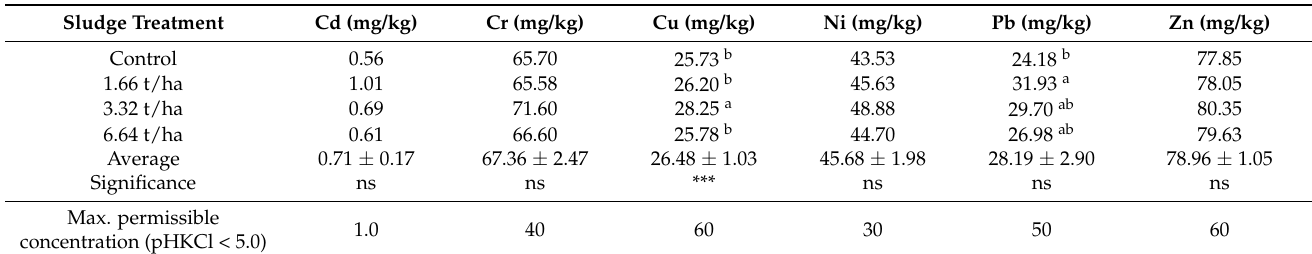
Table 2. Total concentration of heavy metals in soils treated with municipal sewage sludge at a single application rate and planted with